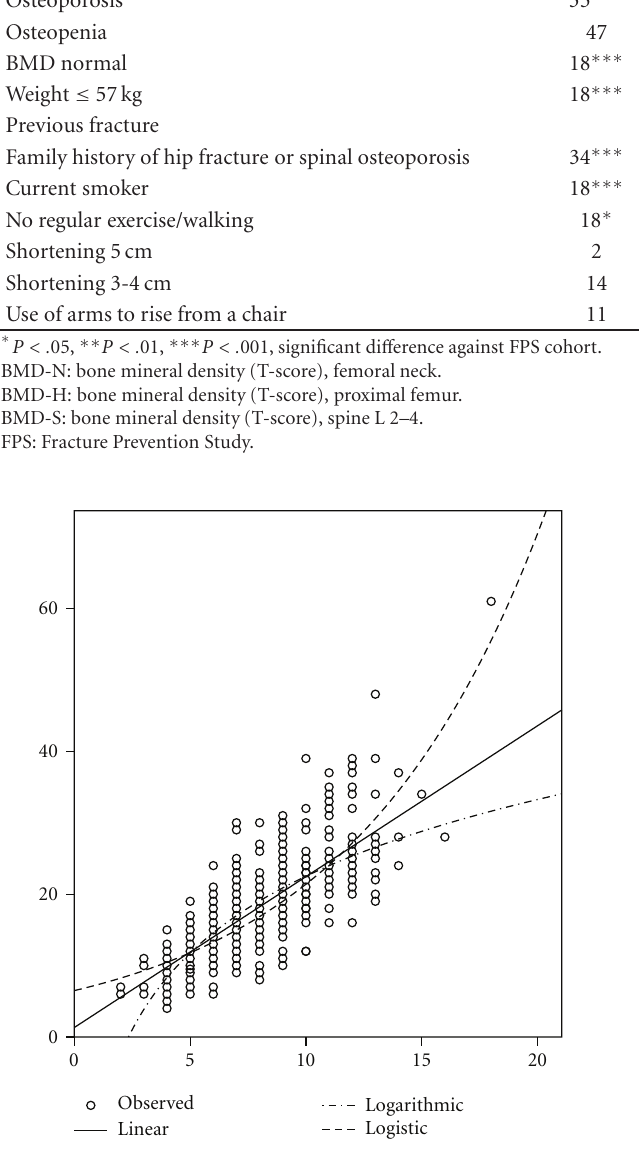
FRAX-BMI was highly significant in the pooled fracture cohort ( R 2 = 0 . 54, F = 596, N = 500, Figure 1). The association of FI and OST with FRAX-BMI was poor ( R 2